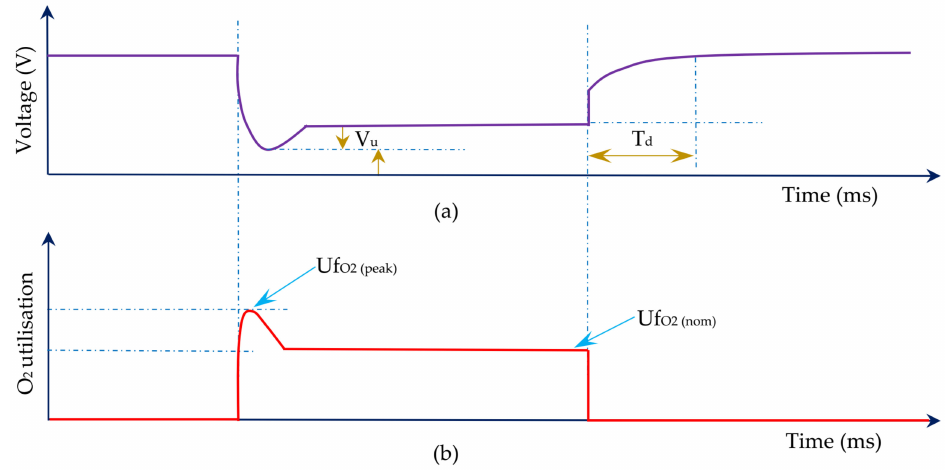
Figure 6. Characteristics of the PEMFC: ( a ) voltage: and ( b ) O 2 utilisation over